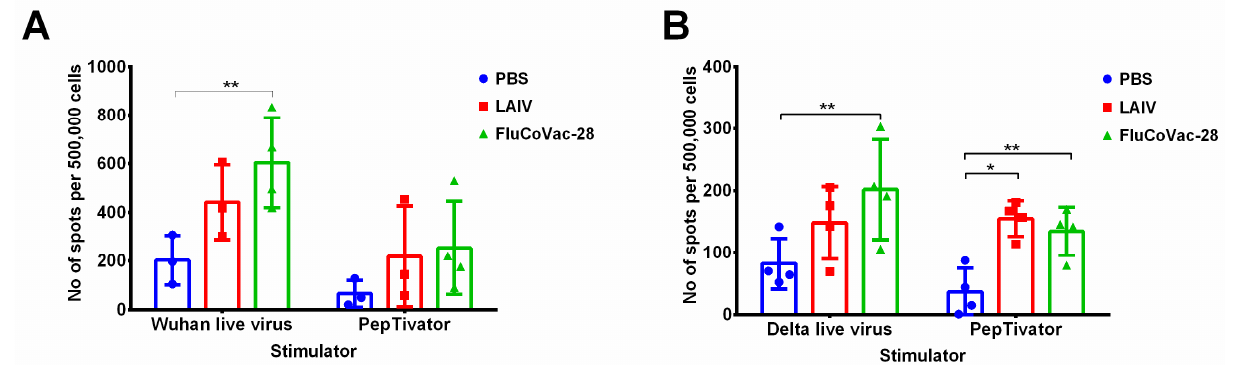
Figure 9. The levels of IFN γ -secreting cells in the splenocytes of immunized Syrian hamsters ( n = 4) on day 5 after challenge with SARS-CoV-2 Wuhan ( A ) or Delta ( B ) variants. Isolated splenocytes were stimulated in vitro either with live SARS-CoV-2 or with PepTivator, followed by quantification of IFN γ -secreting cells by Hamster IFN- γ ELISpot Plus kit. Data were analyzed by two-way ANOVA with Tukey’s post-hoc multiple analyses test. *— p < 0.05; **— p < 0.01.